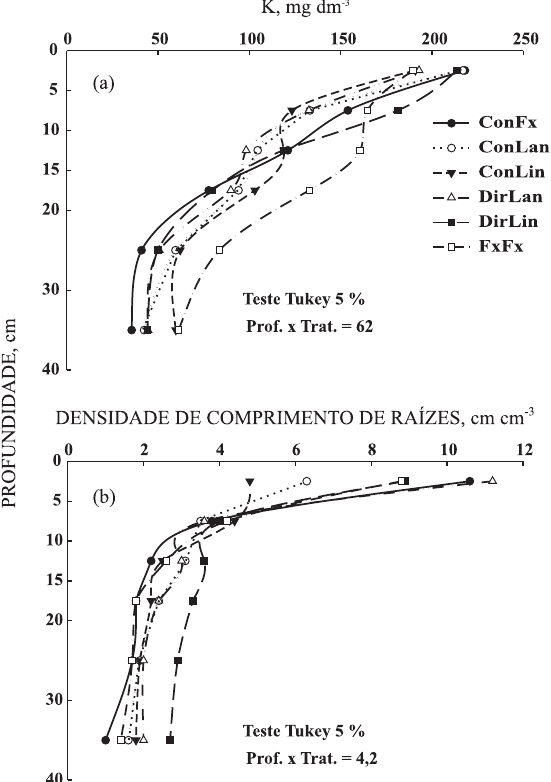
Figura 3. Distribuição de potássio (Mehlich-1) (a) e da densidade de raízes (b) no perfil de um Argissolo Vermelho conduzido por 18 anos em diferentes sistemas de manejo: convencional – faixa (Con/Fx), convencional – lanço (Con/Lan), convencional – linha (Con/Lin), plantio direto – lanço (Dir/Lan), plantio direto – linha (Dir/Lin) e faixa – faixa (Fx/Fx),- safra